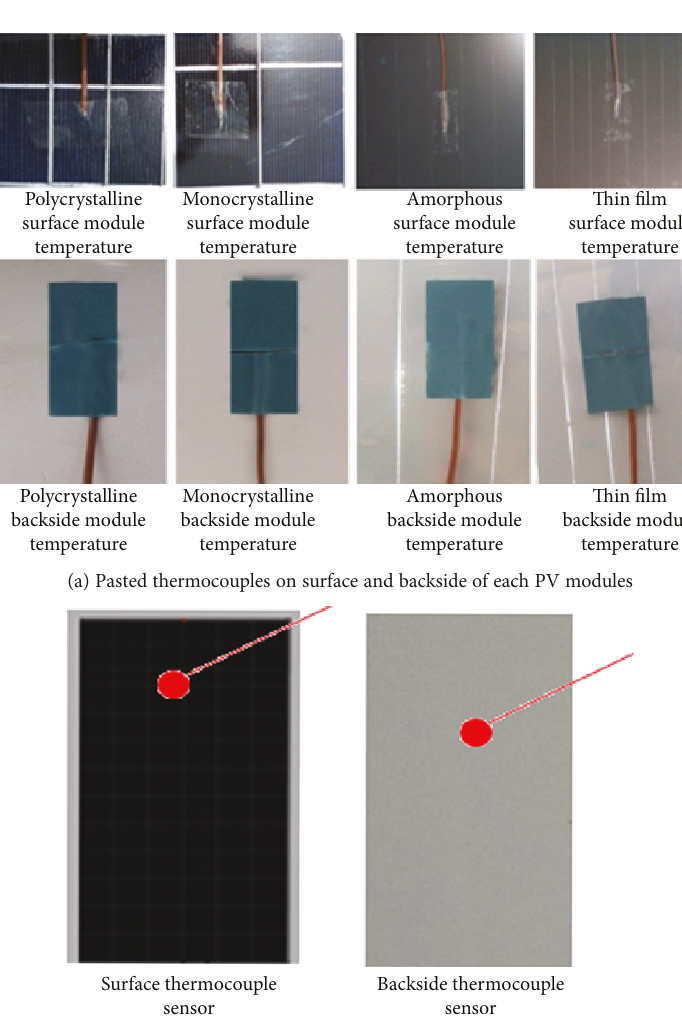
Figure 2: Experimental setup.